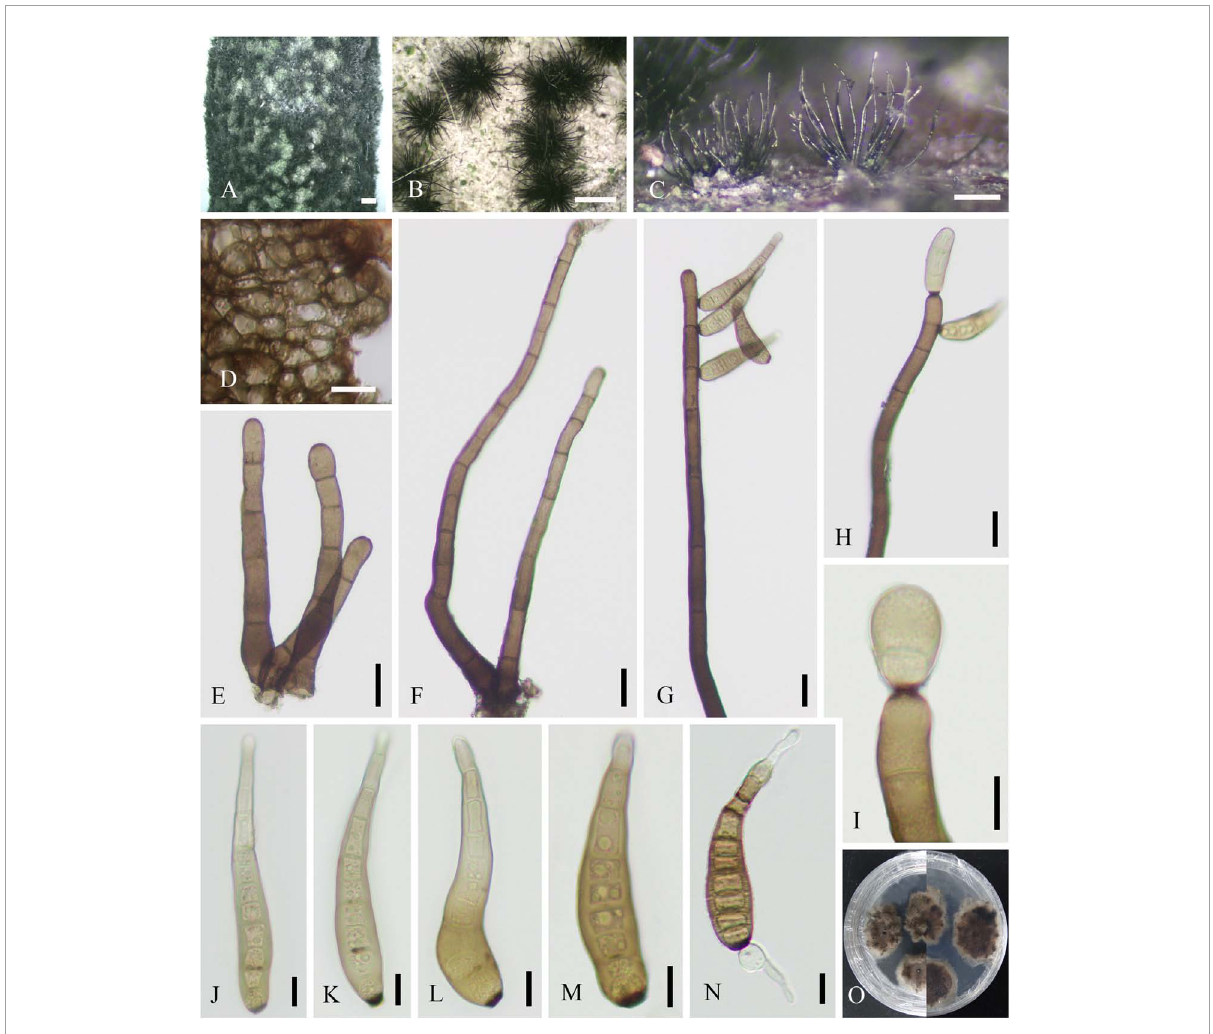
FIGURE3 Helminthosporium juglandinum (SICAU 22-0090). (A–C) Colonies in face view. (D) Stroma cells in section. (E,F) Conidiophores. (G–I) Conidiophore apices with apical and lateral conidia. (J–M) Conidia. (N) Germinating conidium. (O) Colony on PDA for 20 days. Scale bars: (A) 1,000 um, (B) 500 um, (C) 200 um, (D–H) 20 um, and (I–N) 10